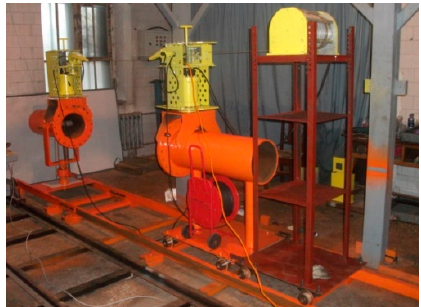
Figure 1. Measuring device based on the outer circle positioning of the pipeline.